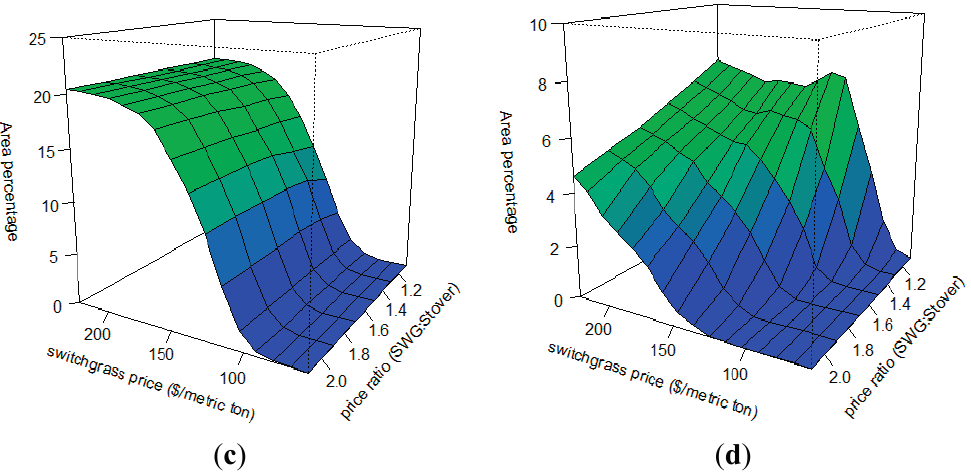
Figure 7. Crop area percentages (( a ) corn—no stover; ( b ) soybean; ( c ) switchgrass; ( d ) corn—stover) from 960 simulations (16 levels of switchgrass price by 6 levels of switchgrass to corn stover price ratio, average of the 10 random samples based simulations for each combination).